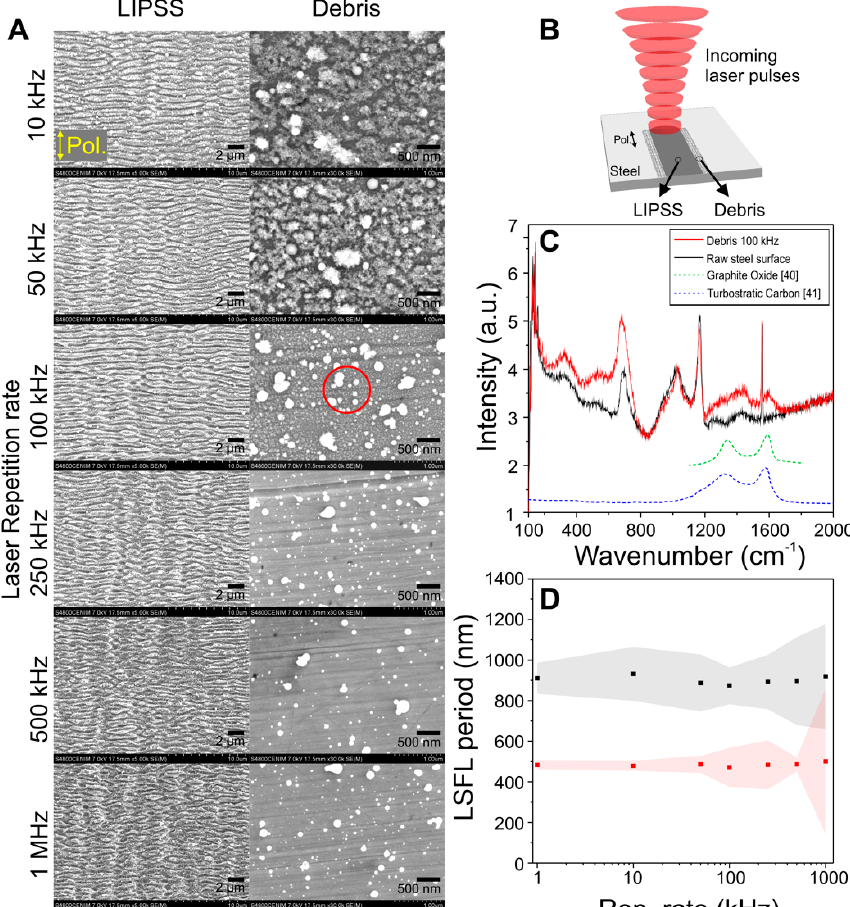
Figure 1. ( A ) SEM micrographs of LIPSS structures and redeposited debris in steel 1.7131, fabricated using a high laser fluence ϕ = 1.5 J/cm 2 , and N eff 1D = 40. Beam polarization is indicated by the double yellow arrow; ( B ) Sketch that indicates the scanning direction and the approximate locations where the images for the LIPSS and debris where taken; ( C ) Micro Raman characterization of the debris-region fabricated at 100 kHz (red circle in A) compared to the clean unirradiated steel surface and to data for graphite oxide and turbostratic carbon from references [40] and [41], respectively. Reprinted (adapted) with permission from Ref. [40]. Copyright 2008 American Chemical Society. ( D ) Plot of the LIPSS periods obtained from FFT maps (not shown) of the SEM micrographs. The major period is plotted in black squares, and the minor period in red circles. The shaded areas correspond to error bars calculated as indicated in Materials and Methods section.